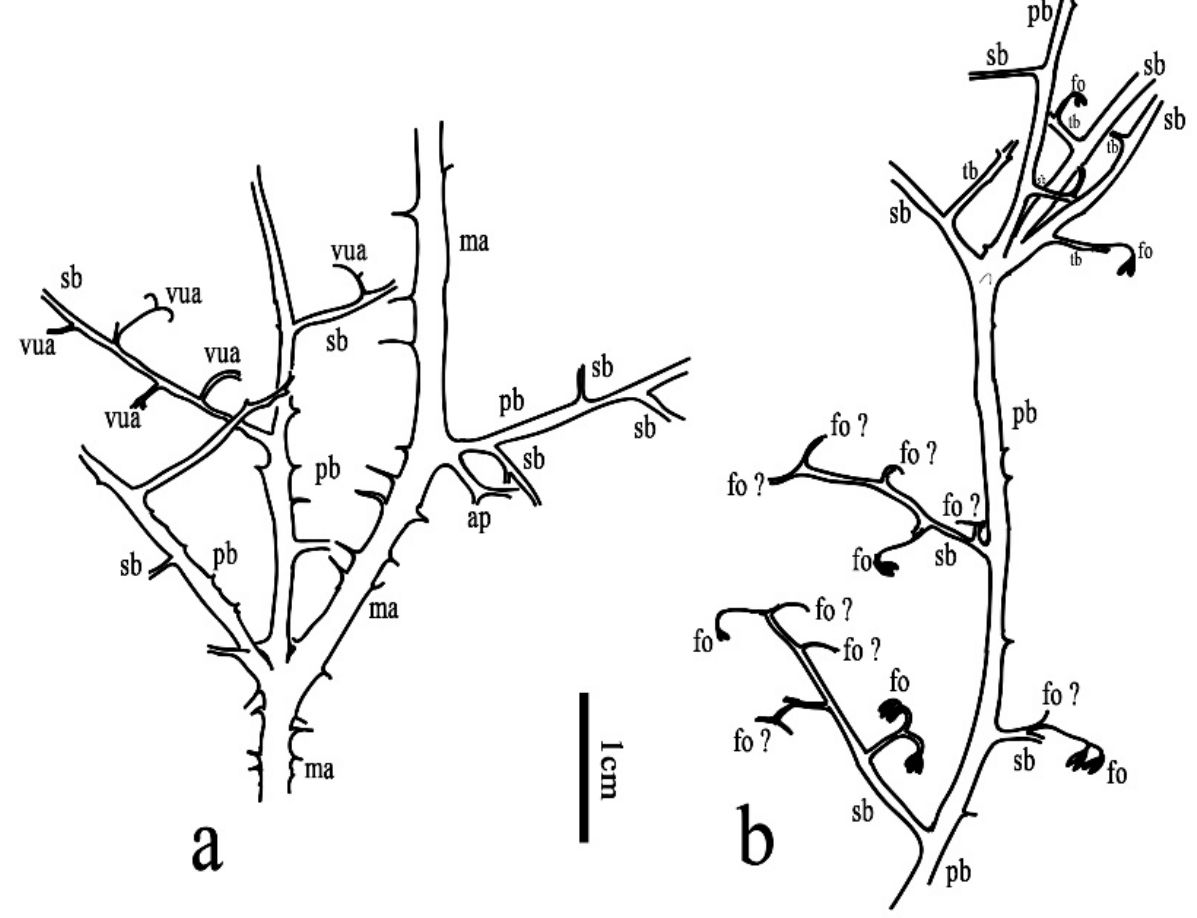
Figure 2. Morphology of Xinhangia spina gen. et sp. nov. from Guangde City, Anhui Province, China. ( a,b ) Line drawing of Figure 1F,H, respectively, ma, main axis; pb, primary branch; sb, secondary branch; tb, tertiary branch; vua, vegetative ultimate appendage; ap: aphlebia; fo, fertile organ; fo ?: assumed fertile organ.